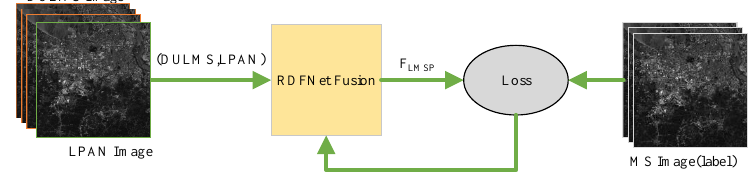
Figure 4. Training workflow of proposed RDFNet.